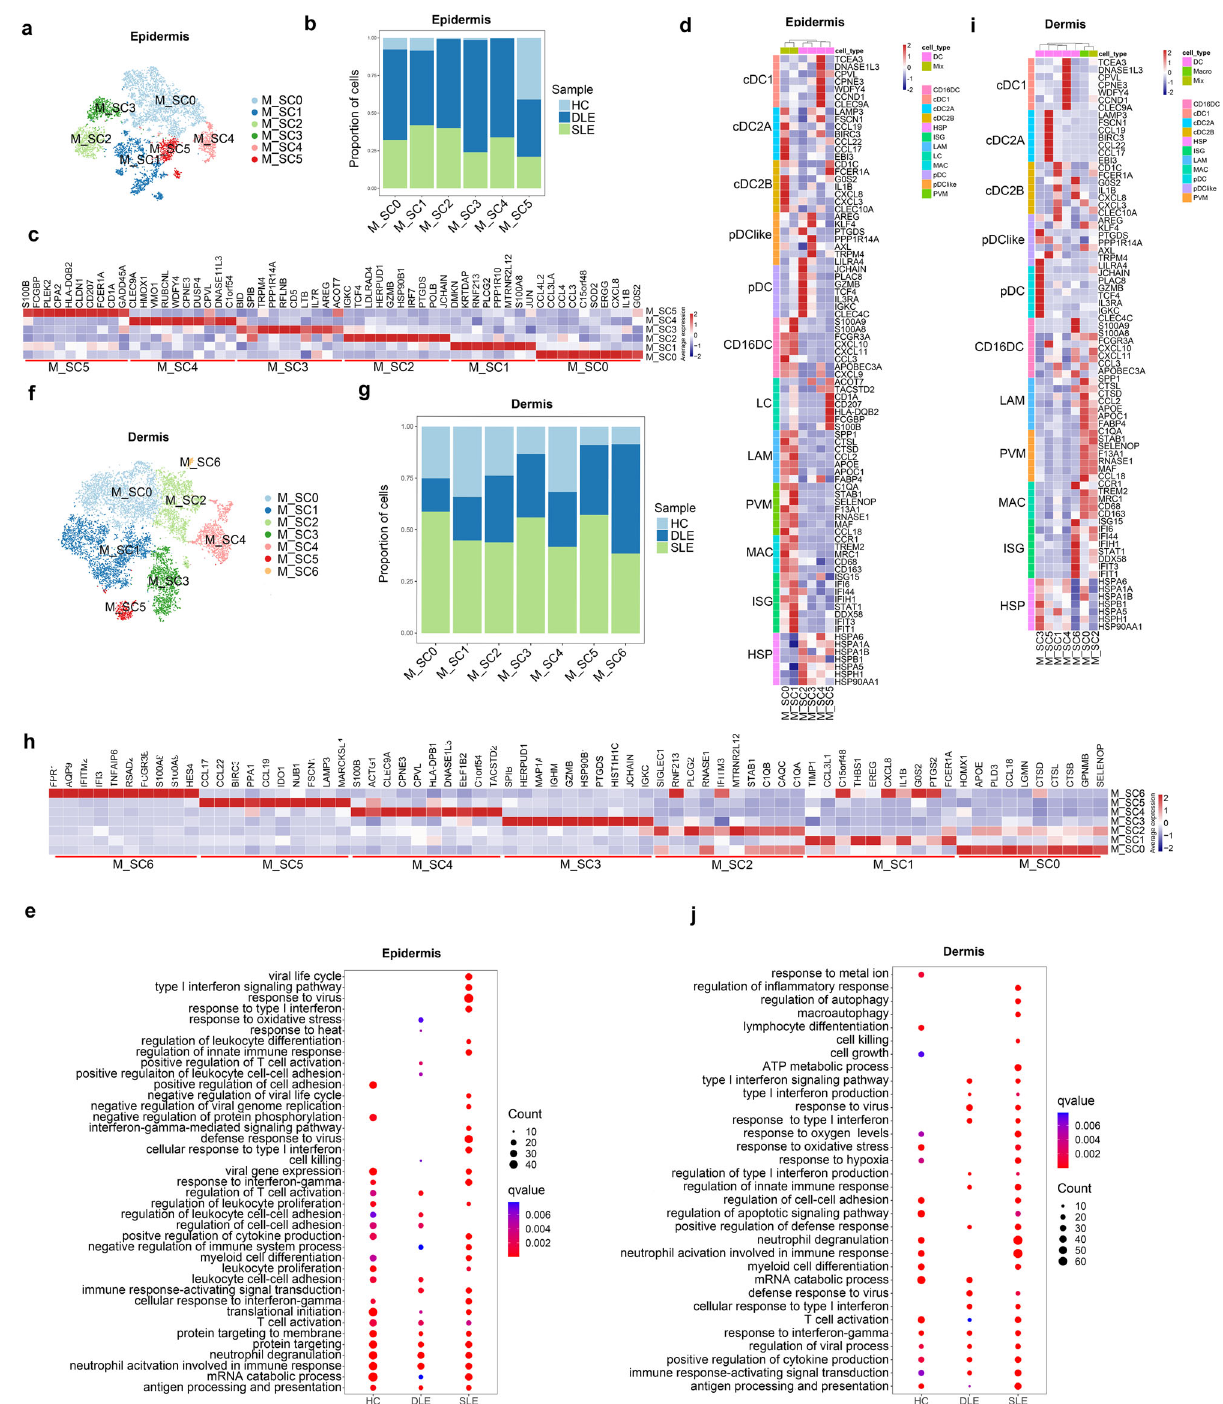
Fig. 7 | Sub-clustering analysis of macrophage/dendritic cells (Macro/DCs) identi fi es major Macro/DCs subclusters. a , f t-SNEs plot epidermal ( a ) or dermal ( f ) Macro/DCs subclusters (SCs) distribution. b , g Bar plots show cells proportions ofHC,DLEandSLEinsixepidermalMacro/DCsSCs( b )andin7dermalMacro/DCs SCs ( g ). c , h Heatmaps display the top 10 differentially expressed genes in 6 epi- dermalMacro/DCsSCs( c )and7dermalMacro/DCsSCs( h ). d , i Heatmapsshowthe